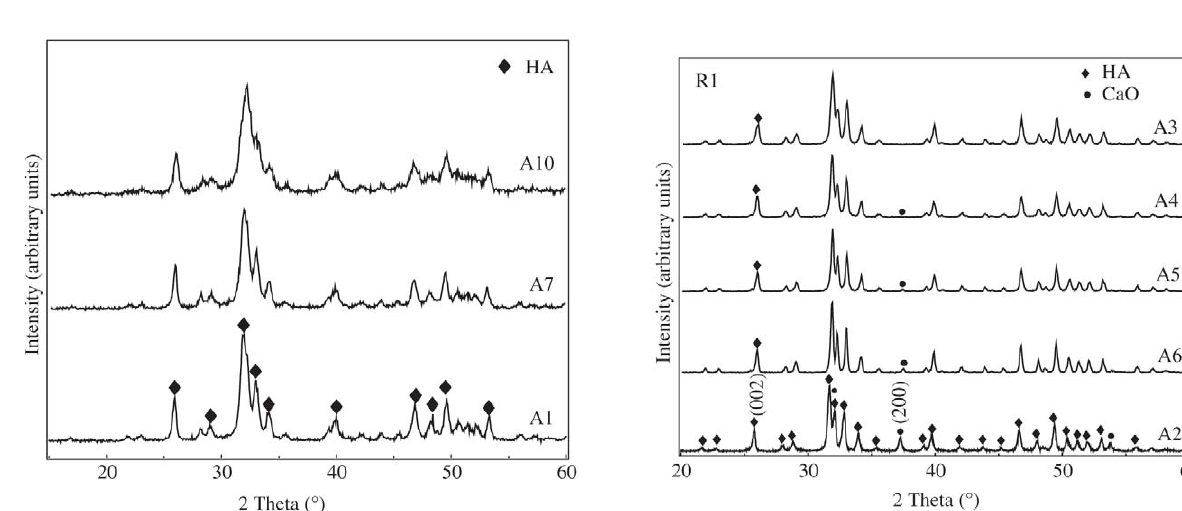
Dominant (+), medium (±), low (-) and trace (*) components.